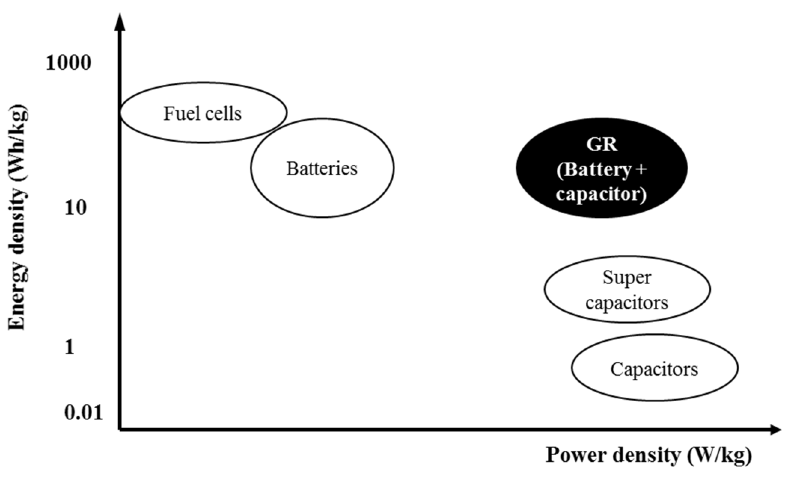
Figure 4. Ragone plot for energy storage devices.